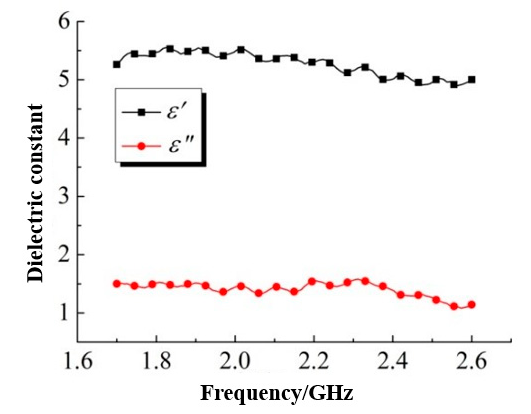
Figure 5. Dielectric constant of limestone gravel.